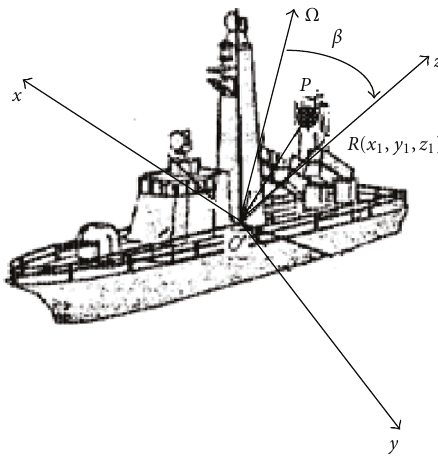
Figure 1: Geometry of ISAR image for ship